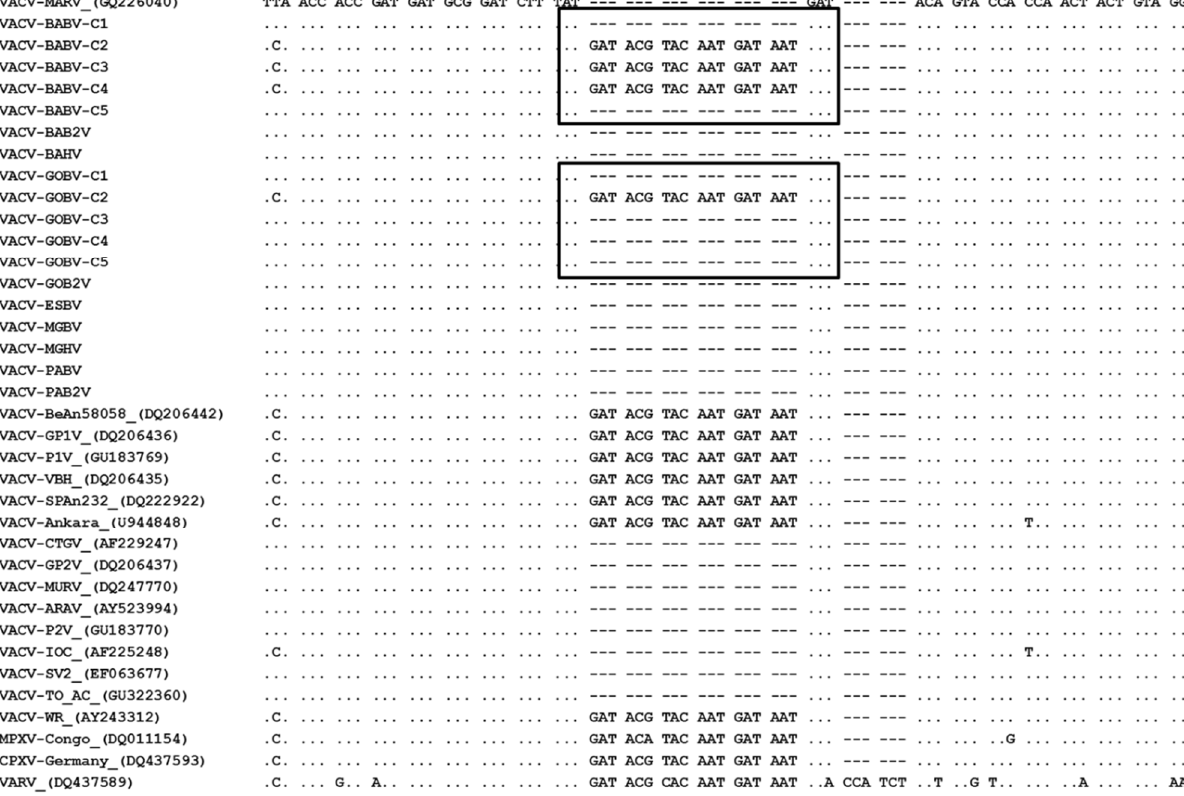
Figure 6. Alignment of a fragment of viral clones A56R gene nucleotide sequences with other Orthopoxvirus sequences. The sequences were obtained from GenBank and aligned using the standard parameters of CLUSTAL W. Nucleotide positions are shown according to the VACV-MARV (G1 VACV-BR isolate). (.) indicates identity and (-) indicates deletion of nucleotides. The box highlights significant variations among clones from the same sample in which the clones 1 and 5 from the VACV-BABV showed a deletion of the 18 nucleotides observed in the A56R gene sequence of G1 VACV-BR, while clones 2, 3 and 4 from the same clinical sample did not show this deletion (G2). This alignment displays only representative clones from each sample, except for VACV-BABV and VACV-GOBV, in which all clones are